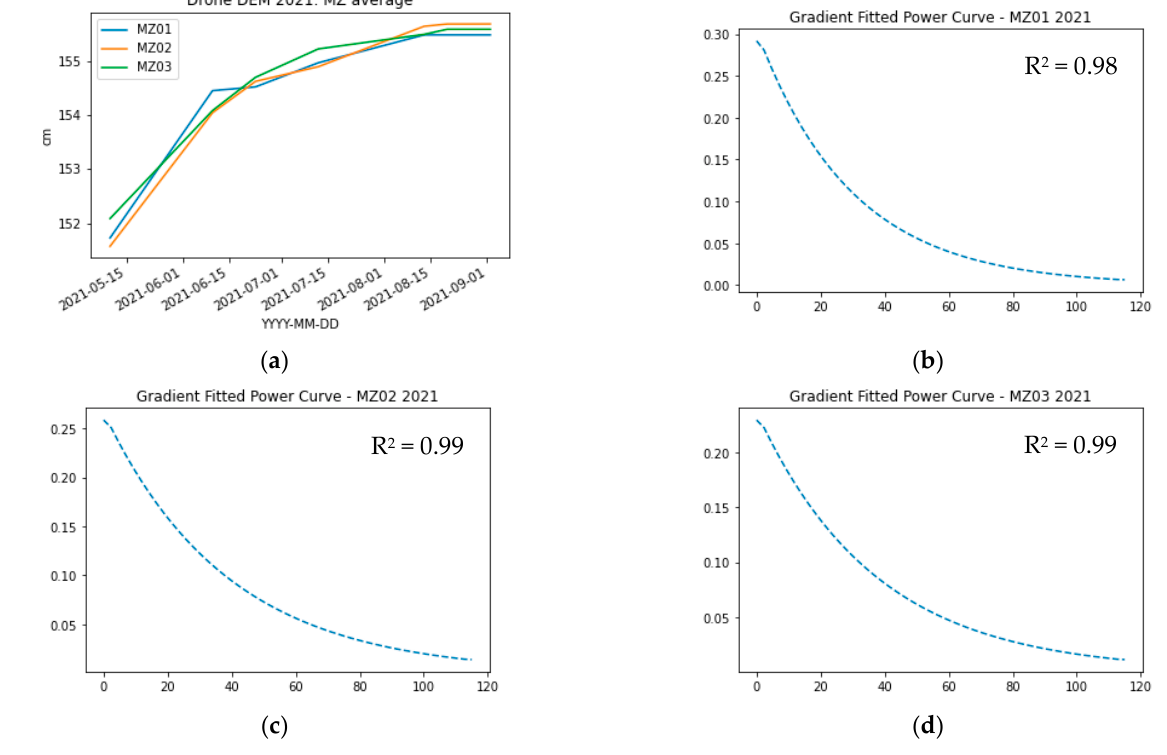
Figure 5. Evolution of plant height (H) over the 2021 growing season until H stabilization: Growth curve (( a )—cm vs date) and growth rate over management zones MZ01 ( b ), MZ02 ( c ), and MZ03 ( d ).